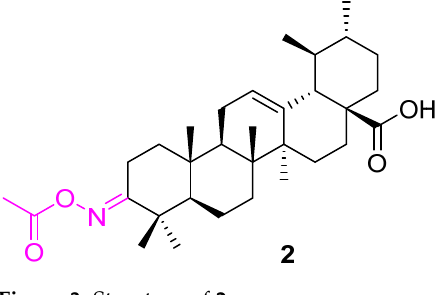
Figure 3. Structure of 2 .